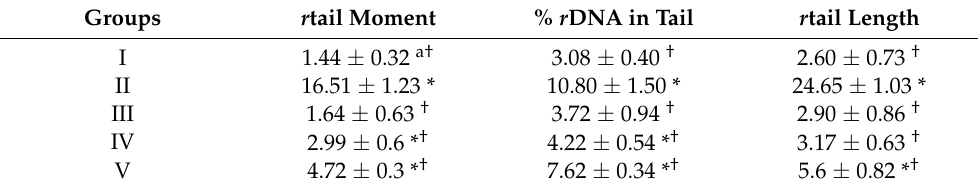
Table 6. DNA damage effect of N. cataria extracts on liver cells of albino Wistar rats.